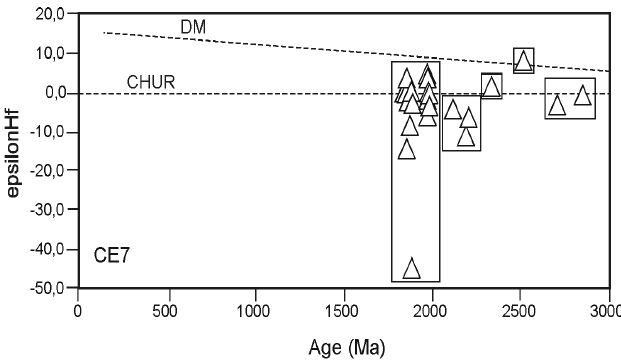
Figure 6 - (A) Backscattered electrons images of some detrital zircon images from sample CE7 (lithic arenite) of the Novo Progresso Formation. (B). Probability density plot of detrital zircon 207Pb/206Pb ages. The main age peaks are indicated. Table 3 - Detrital zircon LA-ICP-MS Lu-Hf results for sample CE7 Zircon/spot